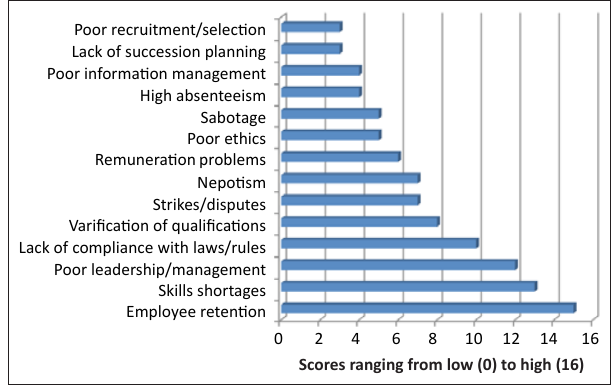
FIGURE 2: Human Resources (HR) risks identified by HR managers.